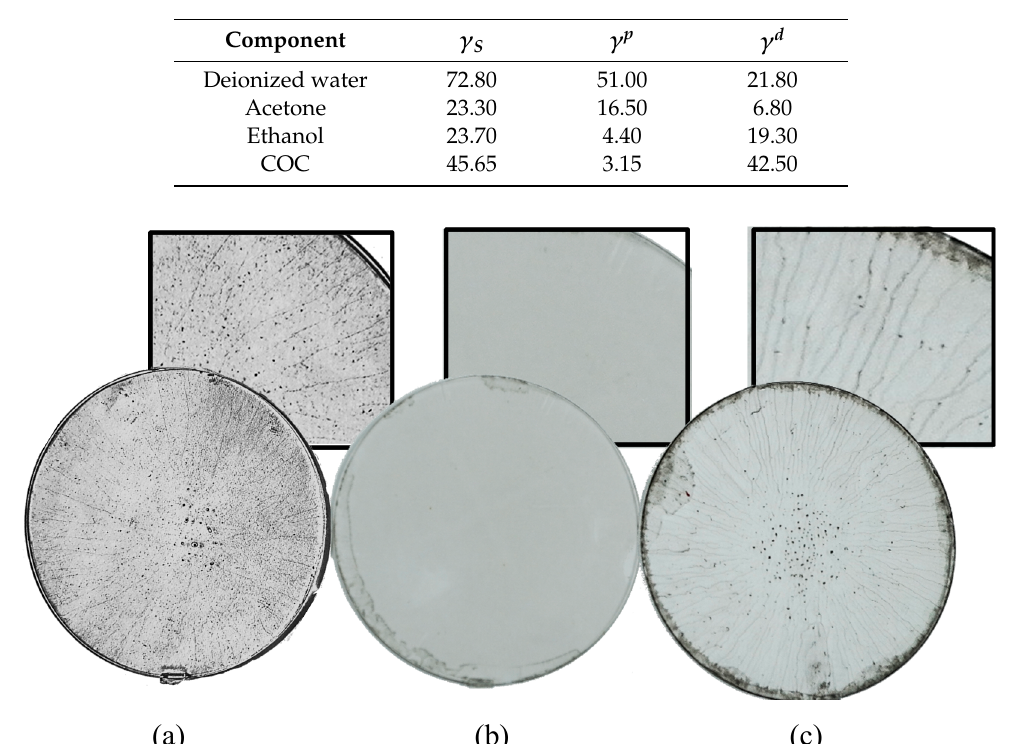
Figure 2. GO single layer spin coated on COC wafer using ( a ) aqueous dispersion of GO, ( b ) water–ethanol dispersion of GO, ( c ) water–acetone dispersion of GO. The concentration of the GO dispersions is 1 mg/mL.